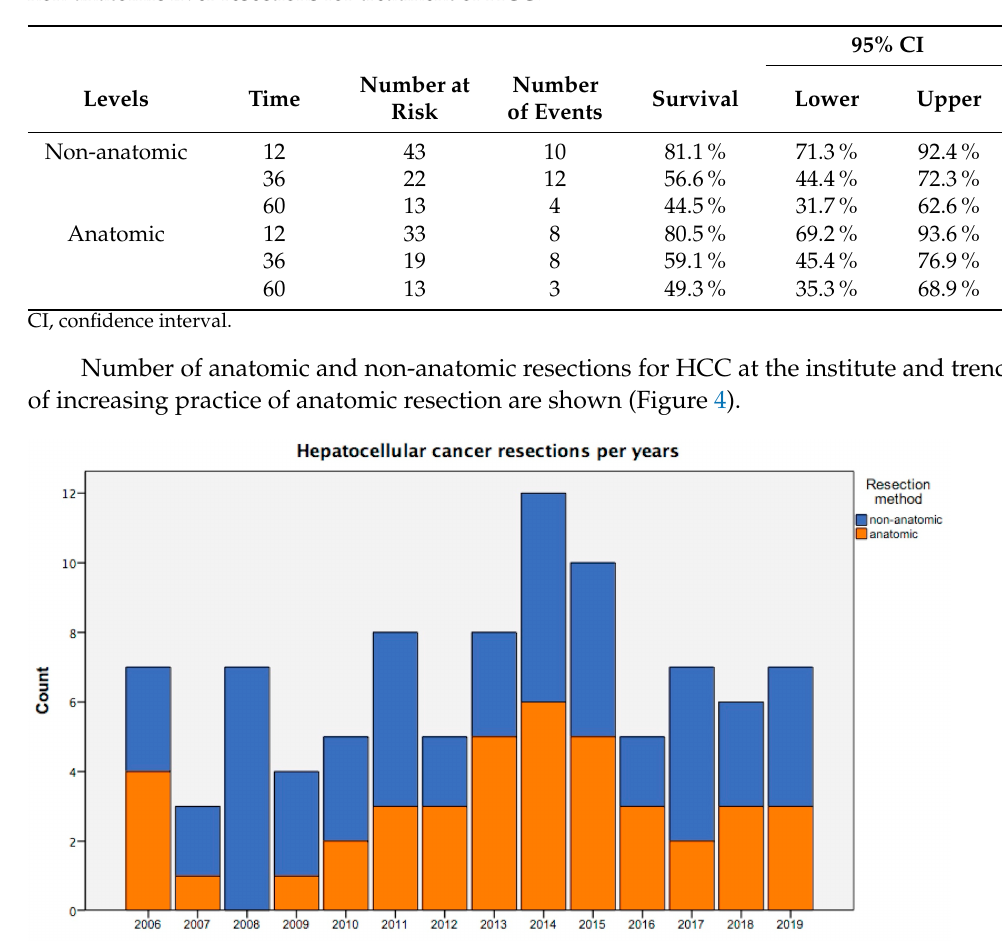
CI, confidence interval. Table 4. The 1-, 3-, and 5-year overall survival rates of patients who underwent anatomic and non-anatomic liver resections for treatment of HCC.